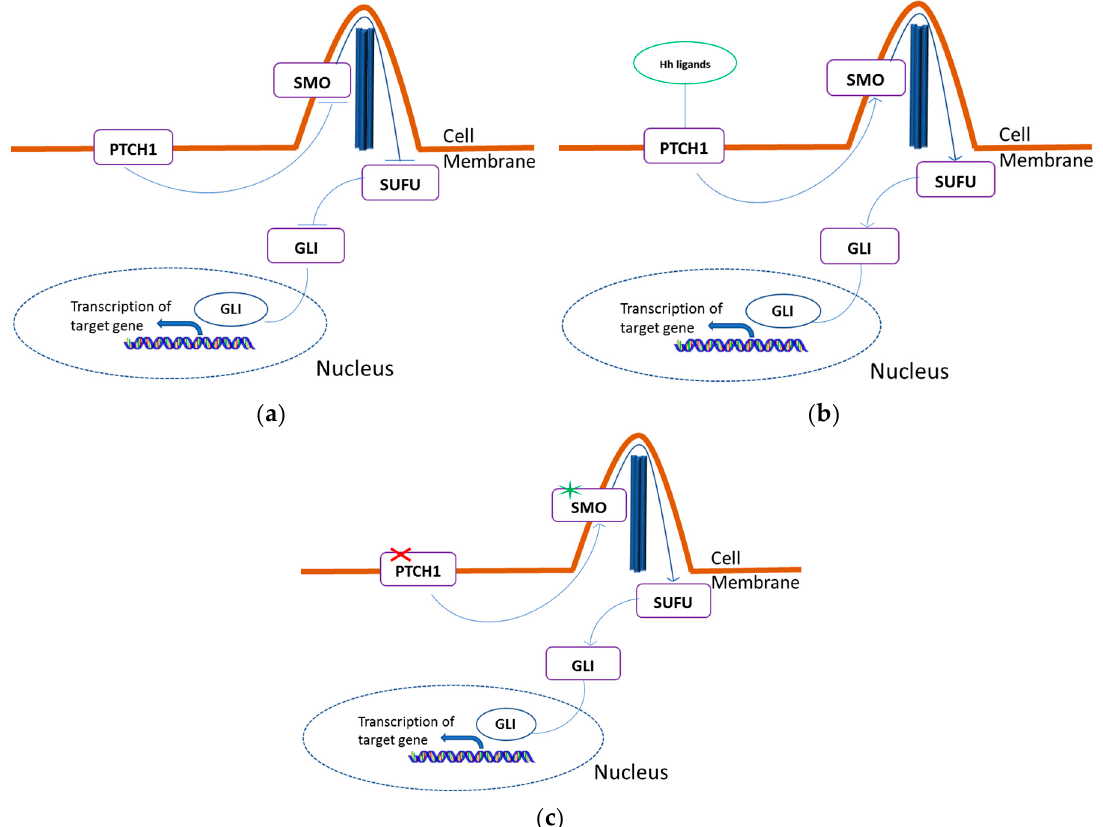
Figure 1. Physiologic and oncogenic Hedgehog signaling. ( a ) In the absence of HH ligands, PTCH 1 constitutively represses SMO , blocking the HH signal transduction; ( b ) The family of extracellular HH ligands binds to PTCH 1, de-represses SMO thereby allowing its translocation on the tip of the primary cilium. SMO sends signals through a series of interacting proteins, including SUFU , resulting in activation of the downstream GLI family of transcription factors; ( c ) Loss of function of PTCH 1 (red cross) or activating mutations of SMO (blue asterisk) induces HH pathway in the absence of HH ligands. HH; Hedgehog; PTCH 1; Patched Homolog 1; SMO ; SMO othened; SUFU ; suppressor of fused; GLI ; glioma-associated oncogene.